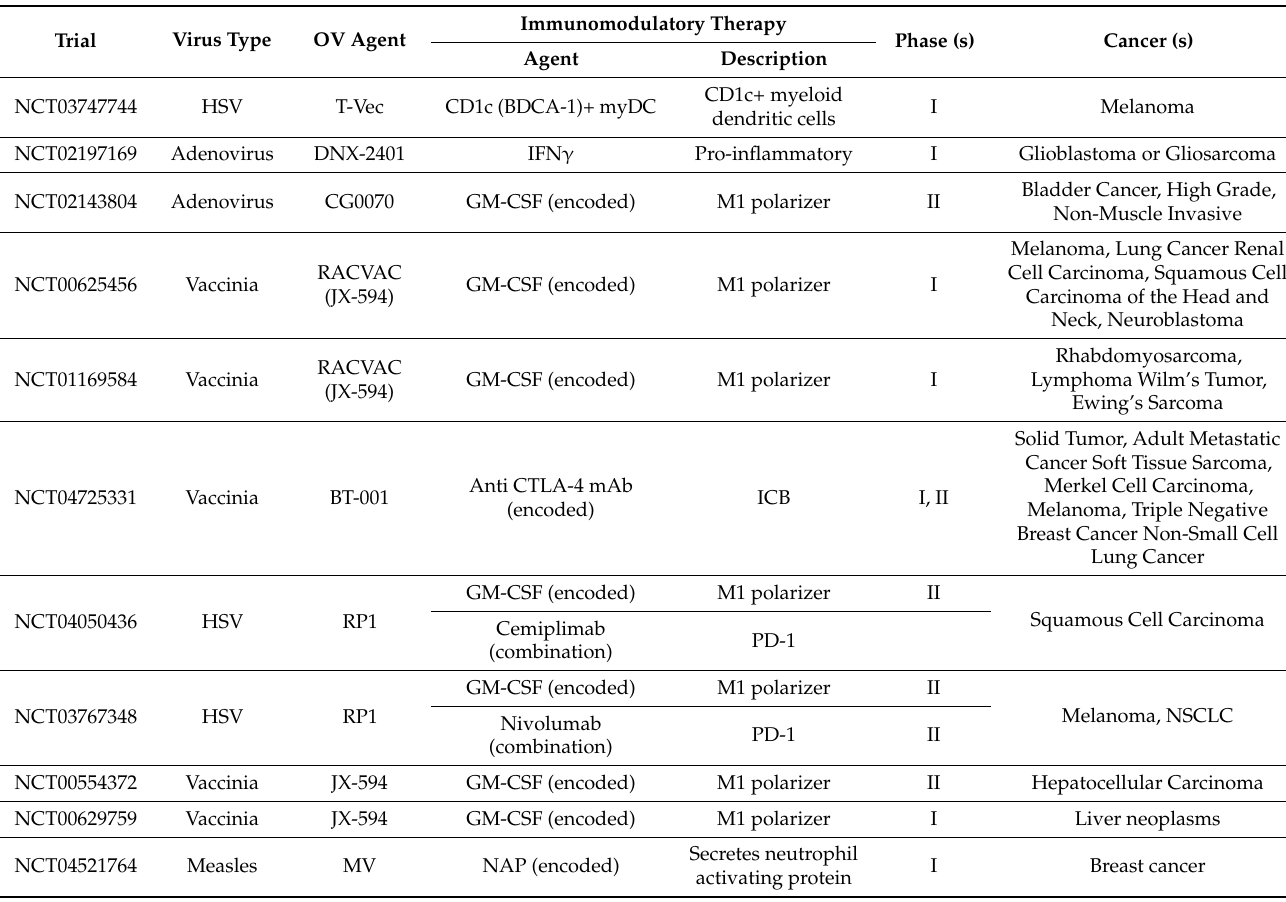
Table 1. List of clinical trials using OVs in combination with immunomodulatory strategies for various cancers.